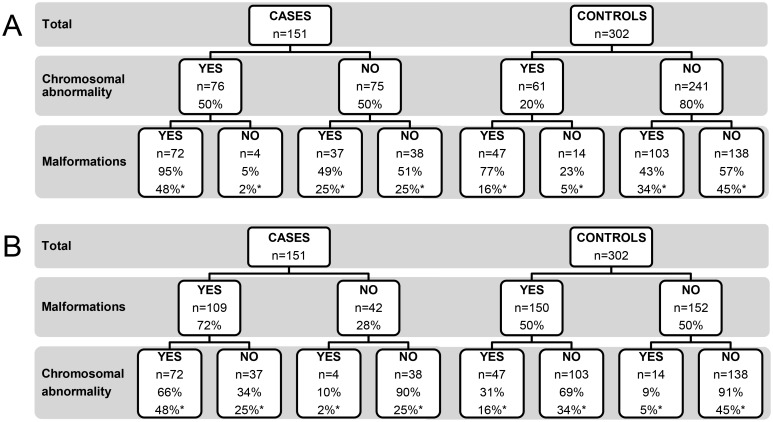
Prevalence of chromosomal abnormalities and malformations in fetal cases with tissue calcifications and controls.(A) Proportion of fetuses with malformations subdivided by the presence of chromosomal abnormalities or not. (B) Proportion of fetuses with chromosomal abnormalities subdivided by the presence of malformations or not. * = percentage of the total number of cases or controls. Percentage without an asterisk refers to the number of subjects in the preceding subdivision.